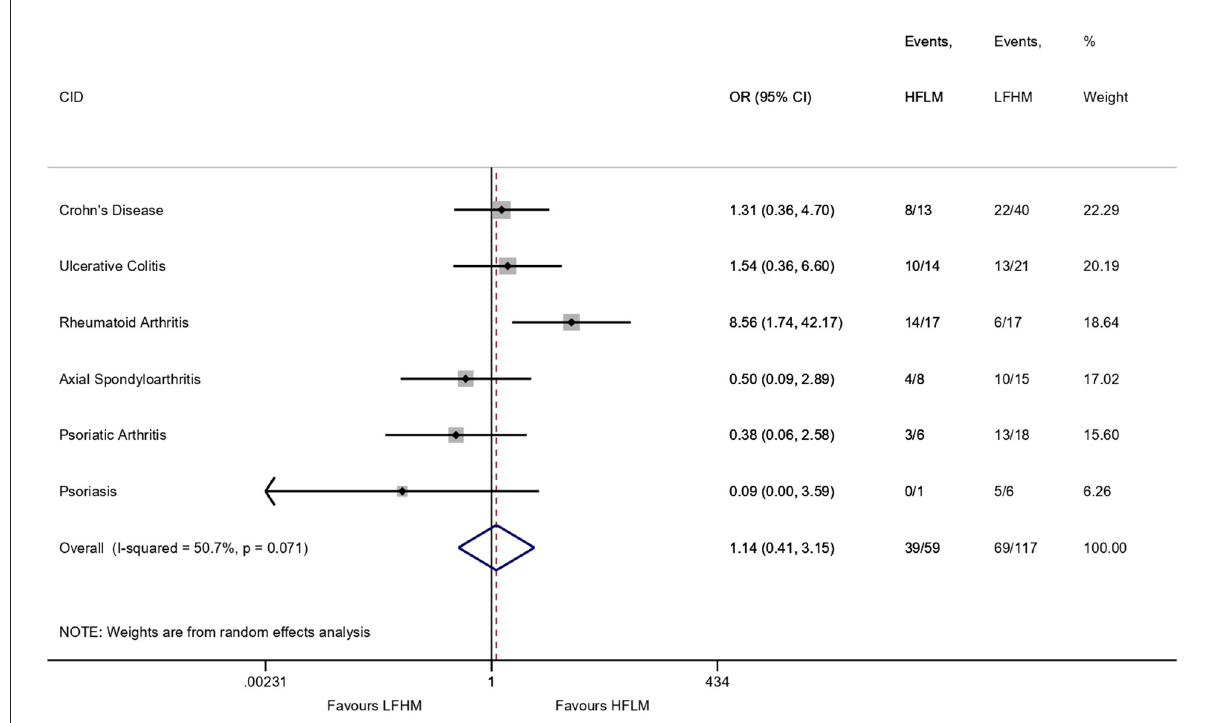
FIGURE2 Meta-analysis (random effects model) of the included Chronic Inflammatory Diseases (CIDs) on the “As Observed” population comparing clinical response to biologics in patients with a high intake of fibre and low intake of red/processed meat (HFLM) vs. patients with a low intake of fibre and high intake of red/processed meat (LFHM). The horizontal lines represent the odds ratio (OR) ± 95% confidence interval. Event = clinical response according to the specified criteria for each CID, i.e., the number shows how many out of the total number of participants in the group, that have had a clinical response. The “As Observed” populations means patients with complete data for clinical response (i.e., 17 patients are excluded).